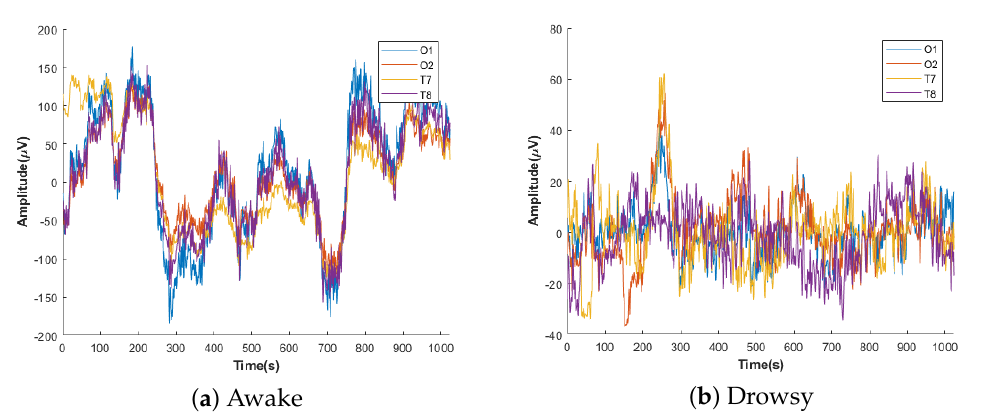
Figure 4. Example annotation of drowsy ( a ) and awake ( b ) of our electroencephalogram (EEG) signal